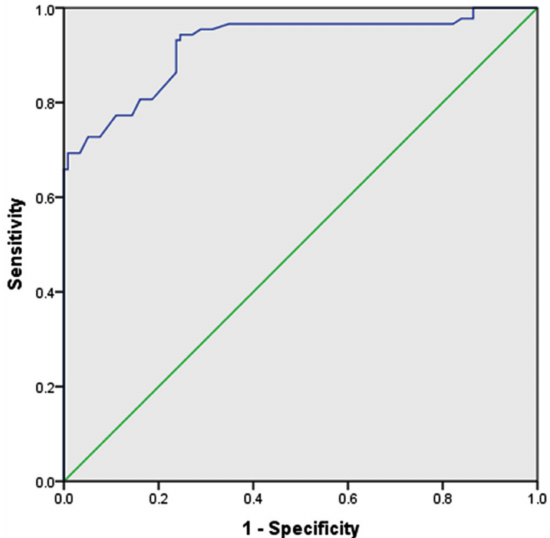
Figure 2. Receiver operating characteristic (ROC) curve for the predictive value of neutrophils count for PCOS. Cut-off value of neutrophil was >46.62 (sensitivity 94.32% and specificity 74.42%) for the prediction of PCOS. The area under the ROC curve (AUC) was 0.922 and Youden index was 0.697 ( p < 0.05). Diagonal segments were produced by